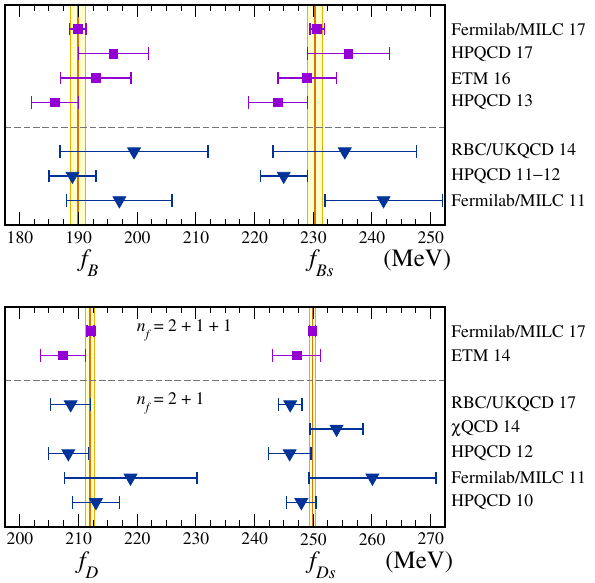
Fig. 5 Comparison of results for the B ( s ) -meson (top) and the D ( s ) - meson (bottom) decay constants. Squares denote lattice-QCD calcu- lations with 2 + 1 + 1 flavors of sea quark [23,27,304–306]; trian- gles denote lattice-QCD calculations with 2 + 1 flavors of sea quark [20,264,285,307–311]. The vertical bands show the FLAG 2019 aver- age for 2 + 1 + 1 sea flavors